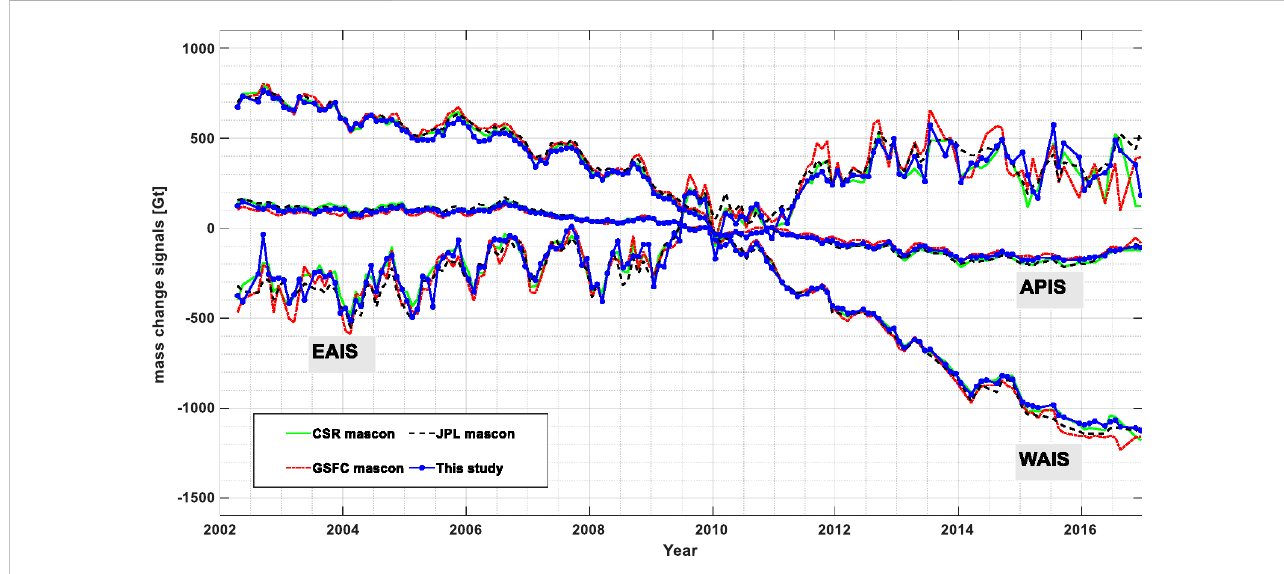
FIGURE 11 Time series of mass change signals over EAIS, WAIS and APIS from April 2002 to December 2016.